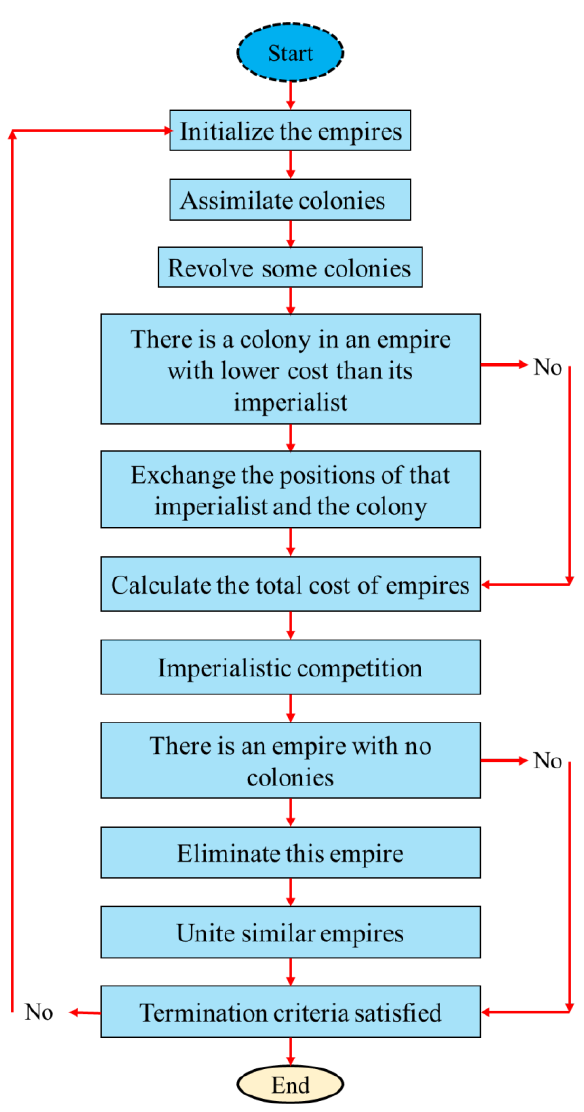
Figure 5. The flowchart of the ICA process (after Moayedi and Armaghani [49]).